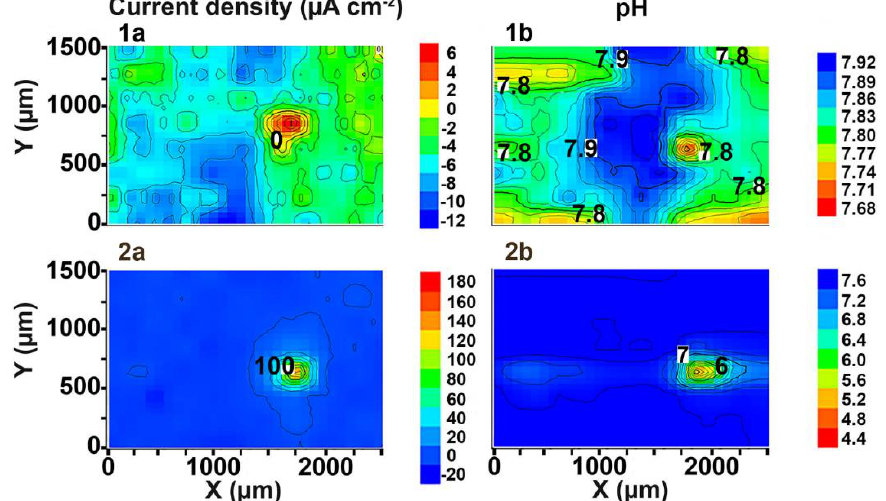
Figure 5. The ( a ) SVET and ( b ) SIET diagrams of the current density and pH distribution on the surface of the welded joint of the 1579 aluminium alloy sample with PEO-coating after ( 1a , 1b ) 90 and ( 2a , 2b ) 98 h of the exposure to 0.5 M NaCl. There is formation and development of the corrosion-active zone on the PEO-coating.